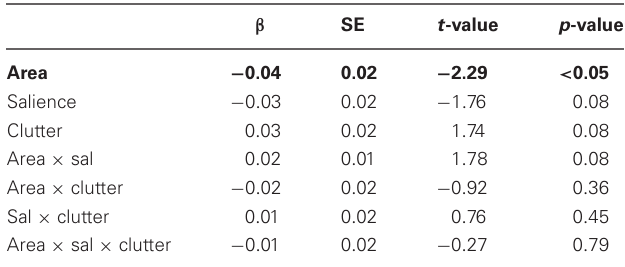
Table 1 | Results of mixed-effects model for predicting number of overall words in a description.